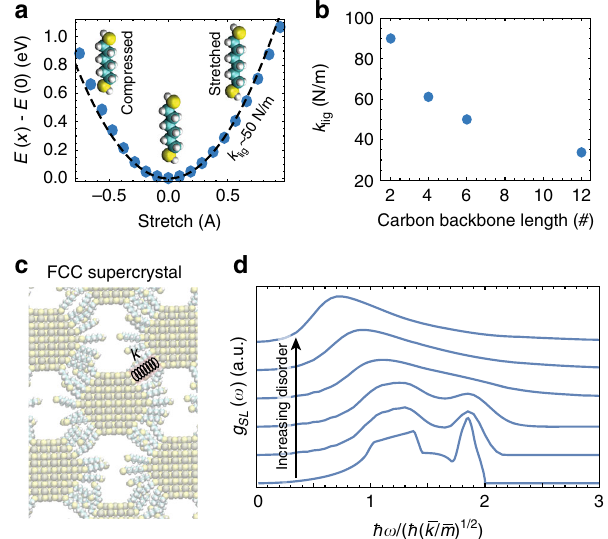
Fig. 2 Modeling the Superlattice Phonon Density of States a The total energy E of an HDT ligand plotted versus the stretch of the ligand, x , shows the characteristic parabolic dependence of a spring. b Computed effective spring constants of dithiol ligands. c Illustration of PbS NC-solids depicting a [100] cross-section through a FCC superlattice. d The expected g SL ( ω ) for an FCC lattice with no disorder (bottom line), and with increasing disorder in the NC masses ( σ m = 10, 20, 50, 100, 200%), and a uniform distribution of spring constants, k ∈ (0.5, 1.5) N/m, i.e., β =